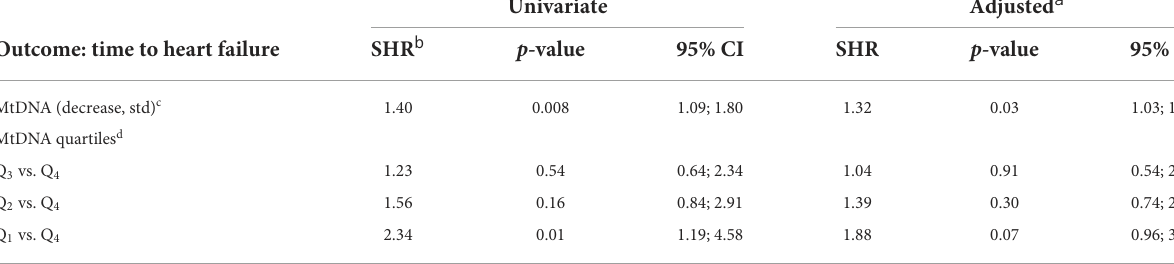
TABLE 4 Effect of mtDNA on heart failure using competing-risks regression model by a subdistribution hazard approach (fine and gray). Univariate Adjusted a Outcome: time to heart